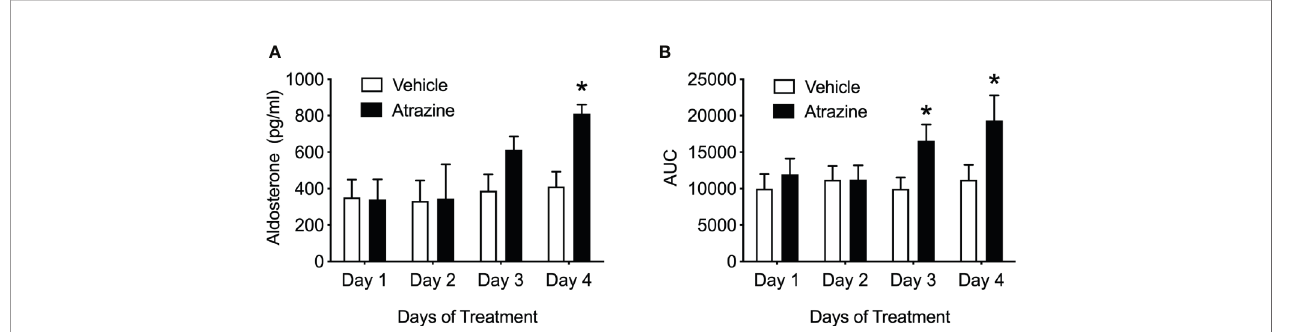
FIGURE 3 | Atrazine treatment increases circulating aldosterone concentrations after angiotensin II over 4 days of treatment. Histograms depicting (A) peak aldosterone concentrations and (B) area under the curve levels in vehicle (white bars) and atrazine (100mg/kg, black bars) after 1, 2, 3, and 4 days of treatment.